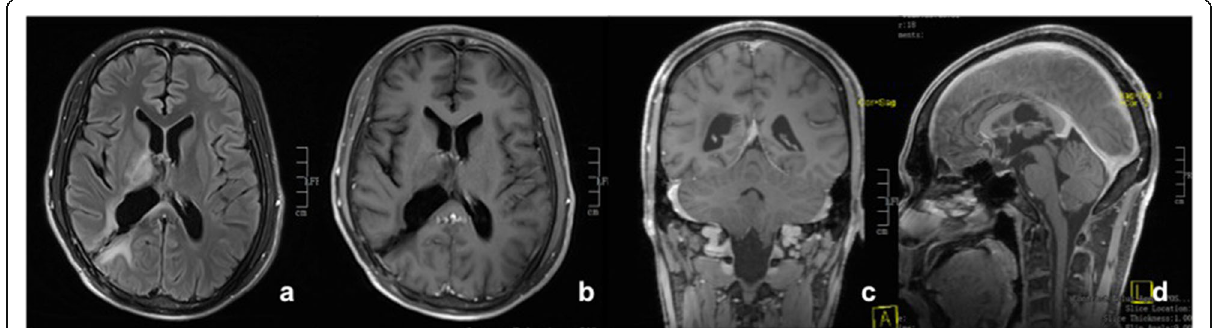
Fig. 5 a Axial T2 FLAIR and b – d axial, coronal, and sagittal sections on T1 contrast MRI of brain showing altered signal involving right thalamus, posterior limb of internal capsule (reduced compared to pre-radiotherapy scans) with no abnormal enhancement in this region. Subtle persistent signal alteration in the medial left thalamus. Mild persistent focal leptomeningeal enhancement seen in right side of superior cerebellar and quadrigeminal plate cistern. No residual enhancing mass lesion in the right lateral ventricle or corpus callosum